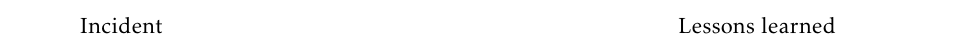
Table 4: [cont.] – UAS incidents experienced by the authors. Incident Lessons